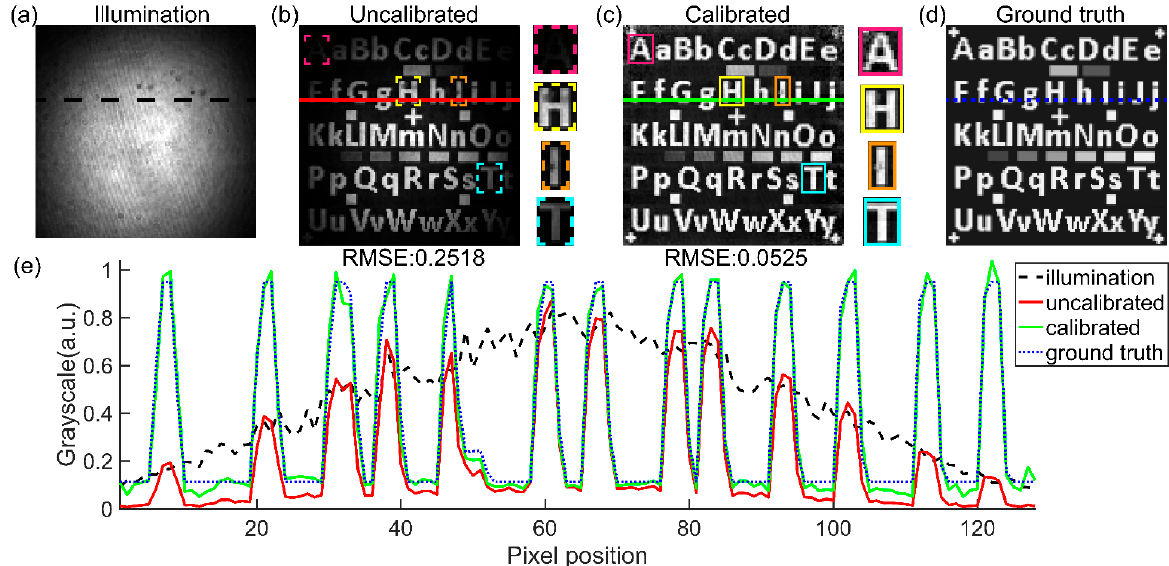
Figure 4. Experiment results. ( a ) Calibration result of light source, which was a reconstructed image of a white paper. ( b ) Uncalibrated reconstructed image; the peripheral area of the image was ambiguous due to the weak illumination. The RMSE of the uncalibrated image is 0.2518. ( c ) Calibrated reconstructed image; the letters in the peripheral area became visible. The RMSE after calibration is 0.0525. ( d ) Ground truth image. ( e ) Gray scale distributions of the images highlighted by the black dashed line in ( a ), the solid red line in ( b ), the solid green line in ( c ), and the blue dotted line in ( d